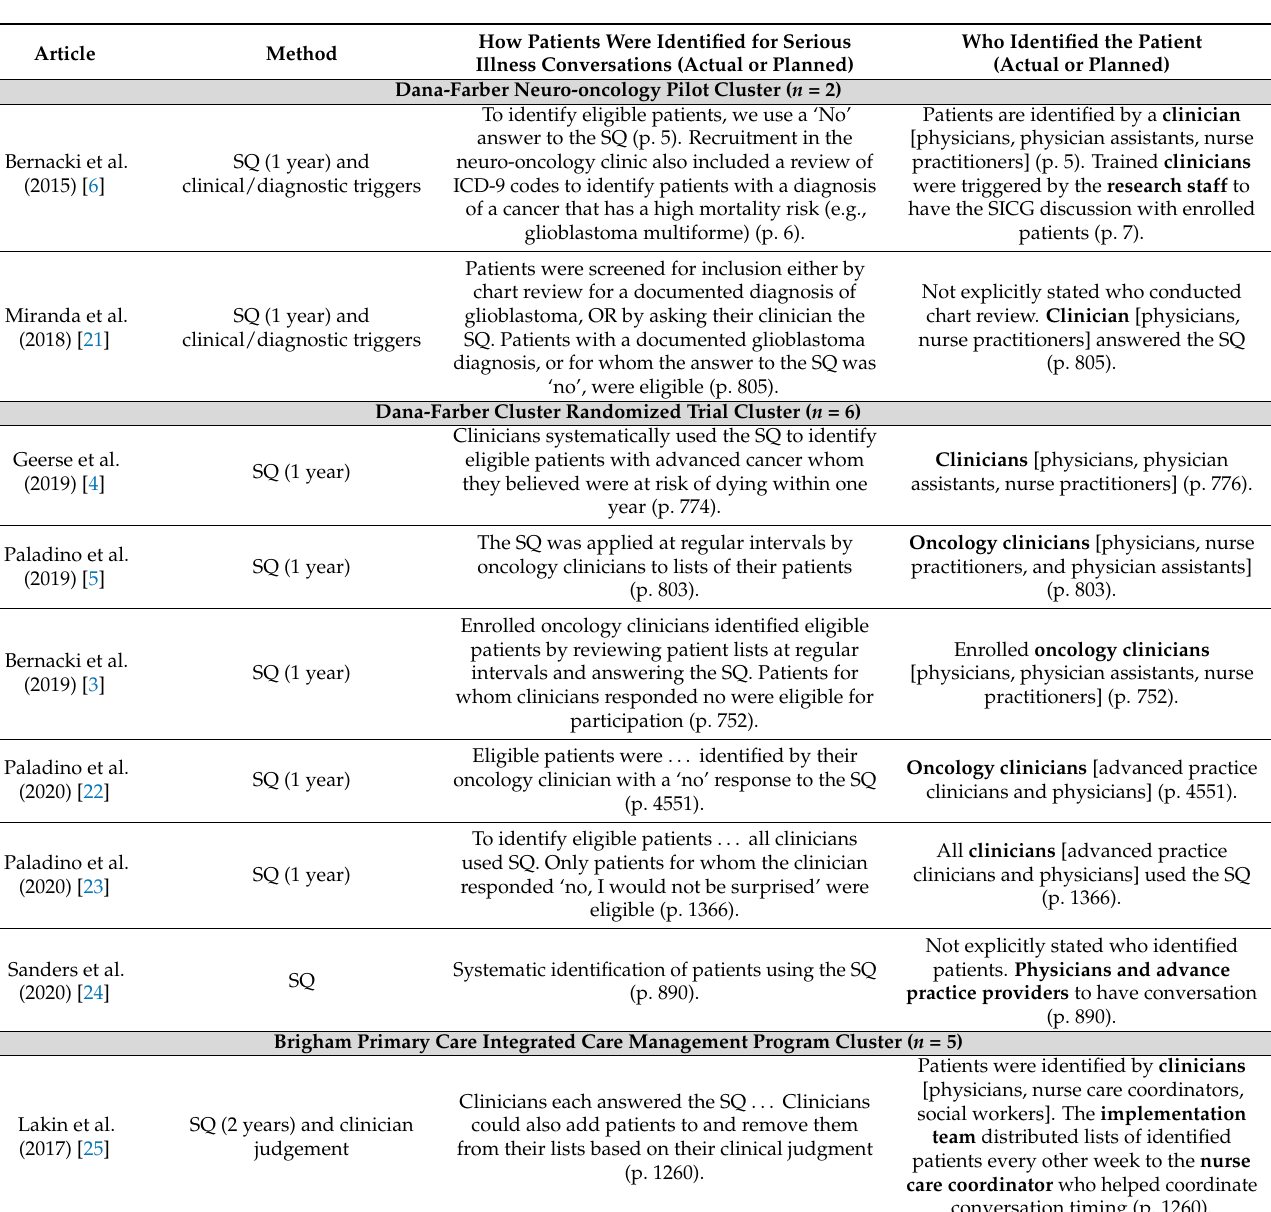
Table 1. Description of patient identification †